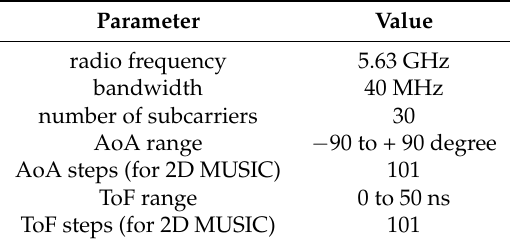
Table 1. Simulated parameters.